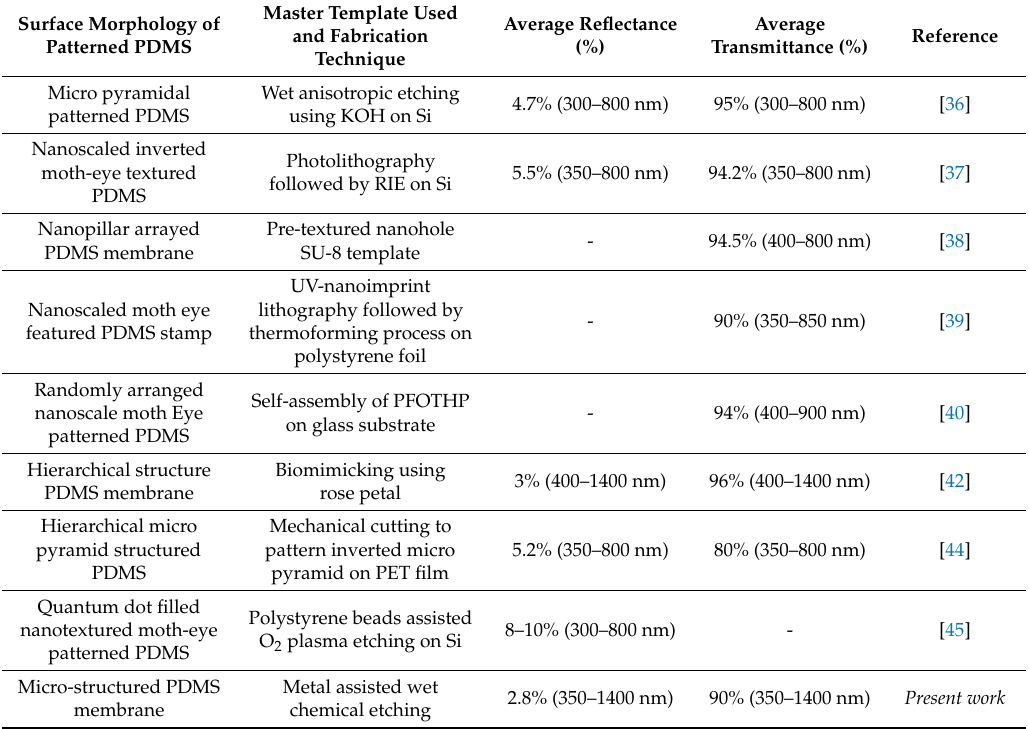
Table 2. Comparative summary of literature reports outlining the recent progress in the realization of patterned